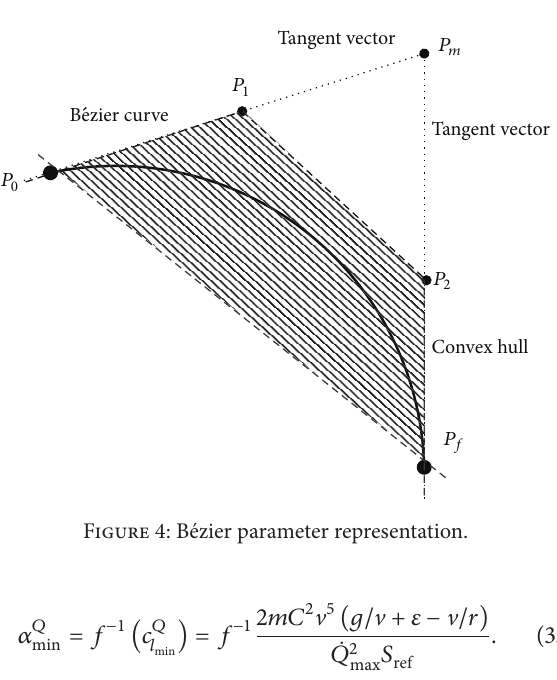
Figure 4: B´ezier parameter